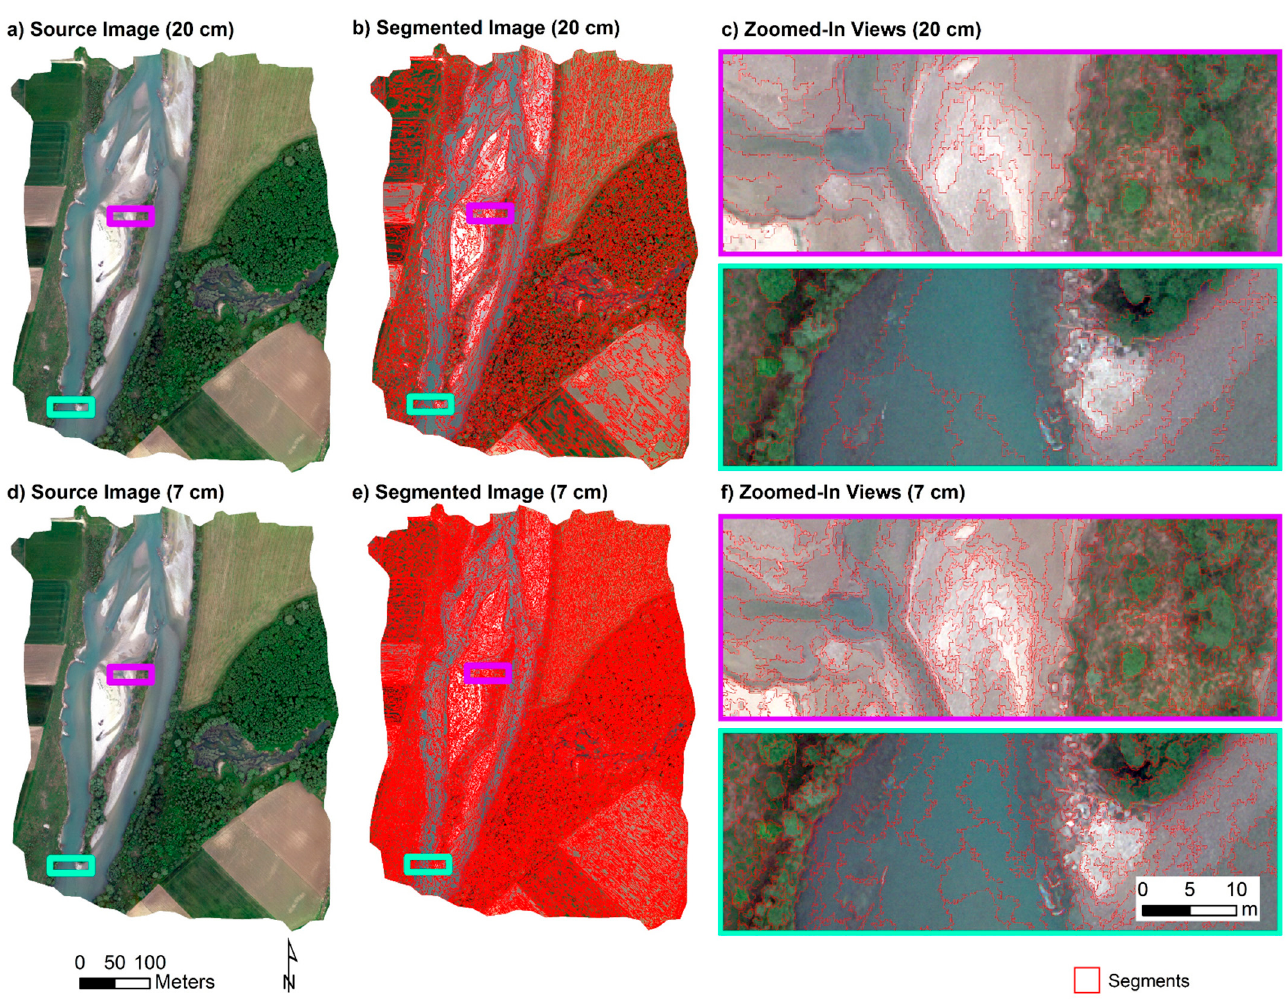
Figure 2. ( a ) Narrow-band image from 17 May 2016 of the River Drau study area with 20 cm pixel size (bands 797, 670, and 550 nm as R,G,B); ( b ) Image segments generated using eCognition ® for the 20 cm narrow-band image; ( c ) Zoomed-in views to the source image and segments depicted by the purple and cyan rectangles in ( a ) and ( b ); ( d ) Narrow-band image from 17 May 2016 of the River Drau study area with 7 cm pixel size; ( e ) Image segments generated using eCognition ® for the 7 cm narrow-band image; ( f ) Zoomed-in views to the source image and segments depicted by the purple and cyan rectangles in ( d ) and ( e ).